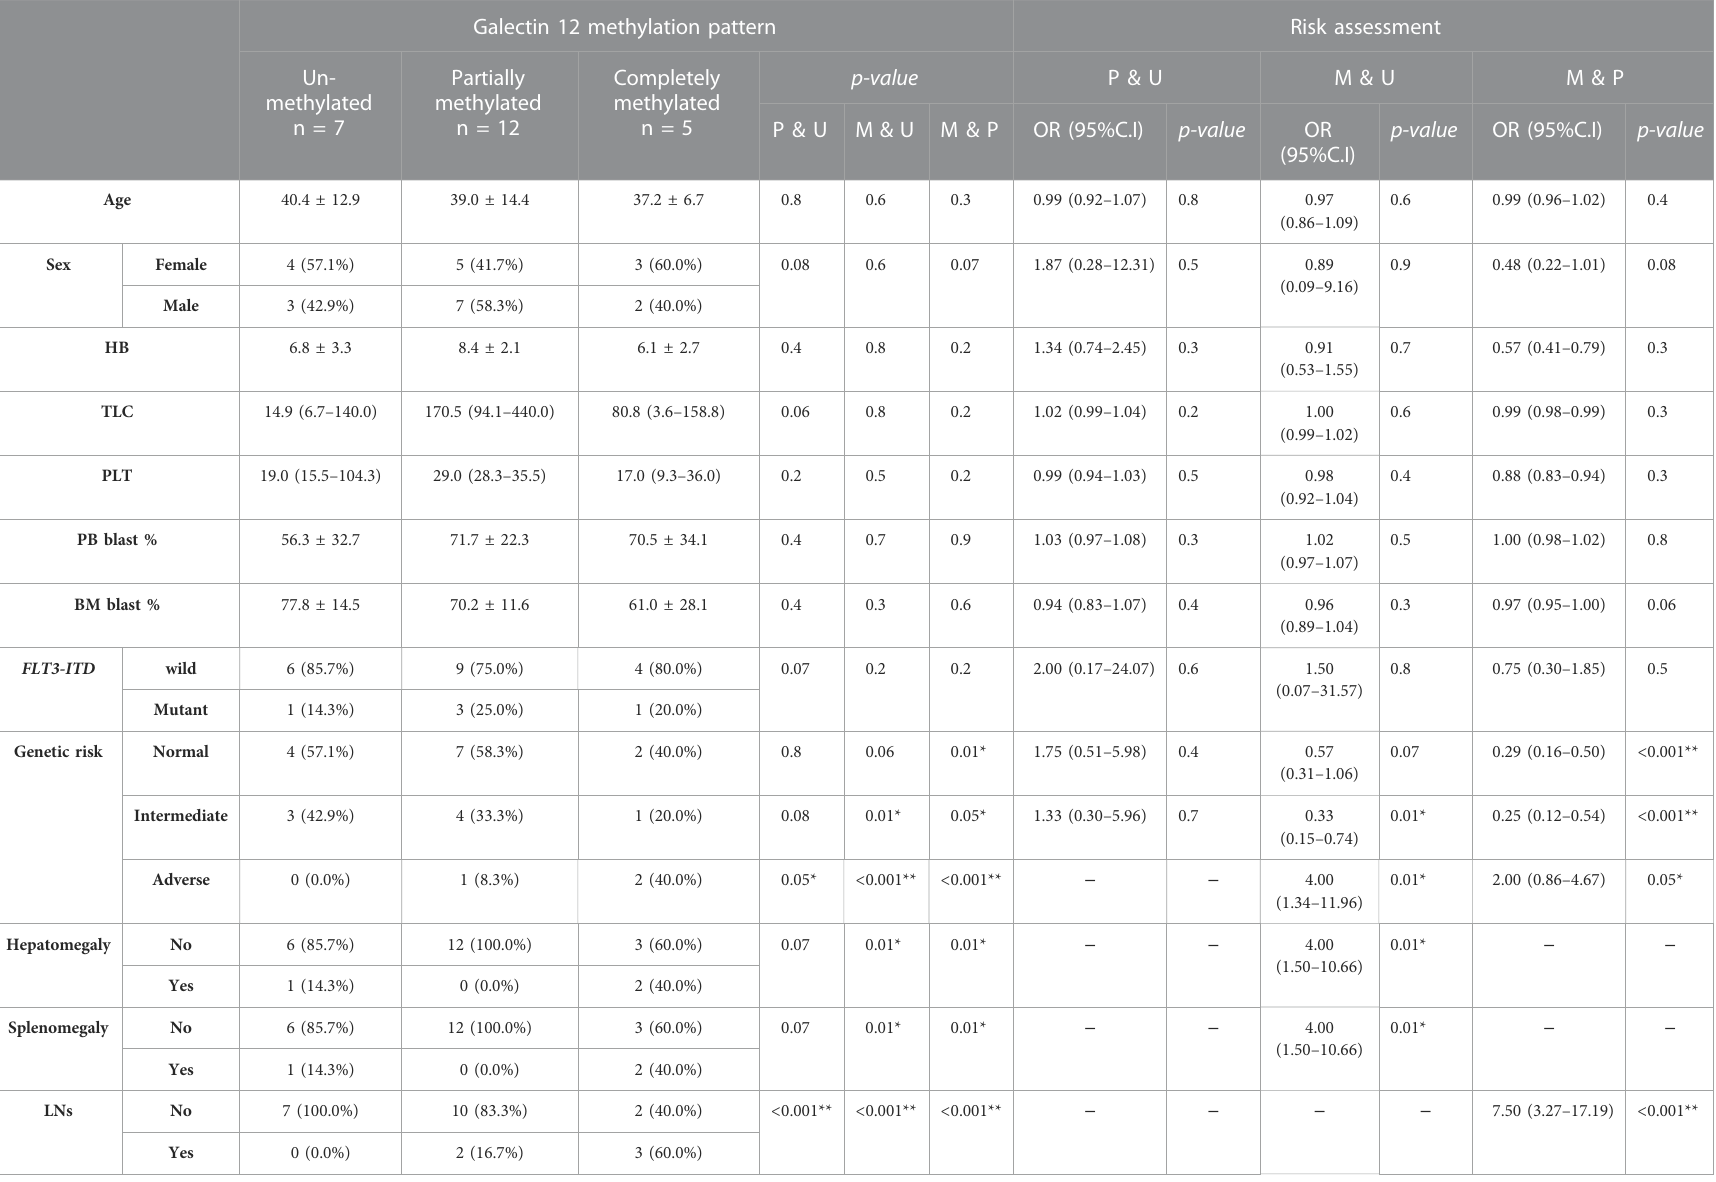
TABLE 5 Relation of the methylation pattern of galectin 12 and clinicolaboratory data of the studied